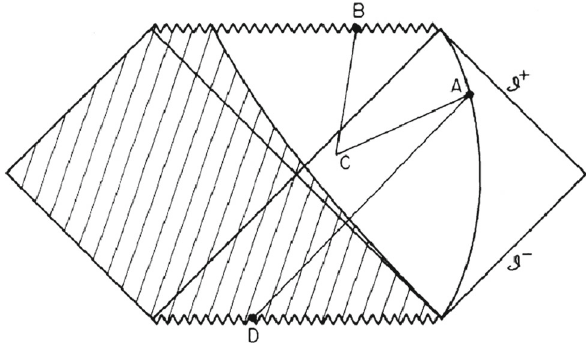
Fig. 1 ThePenrosediagramfortheanalyticalextendedSchwarzschild solution. Figure taken from